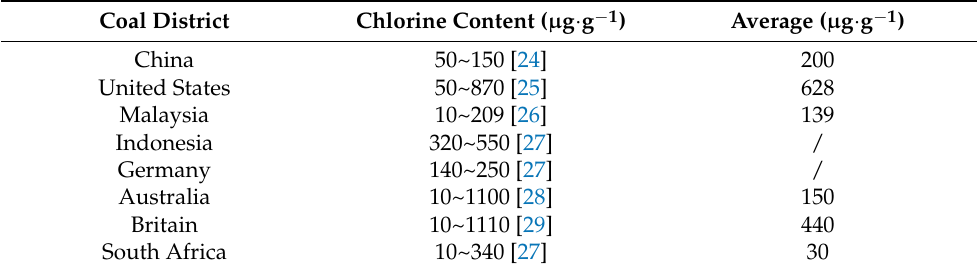
Table 3. Distribution of chlorine content in coals from different regions of the